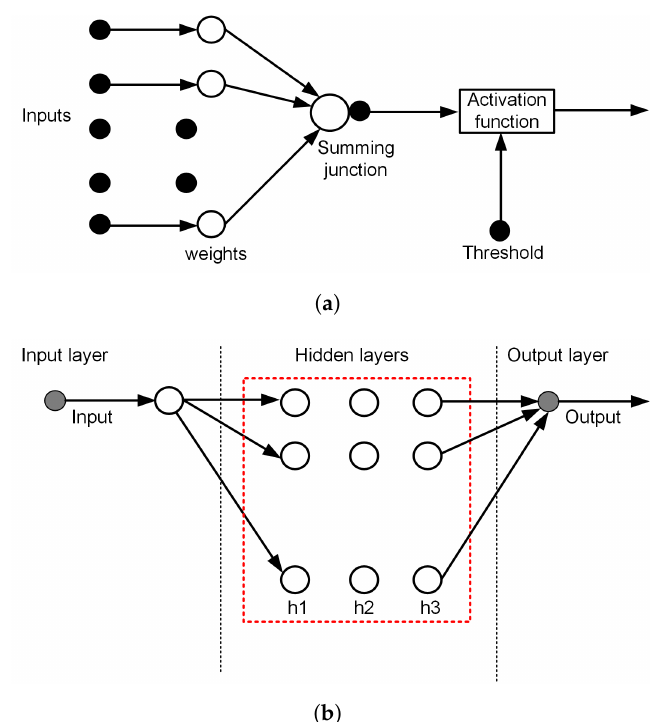
Figure 3. Basic ANN construction. ( a ) Basic neuron construction [49]; ( b ) ANN